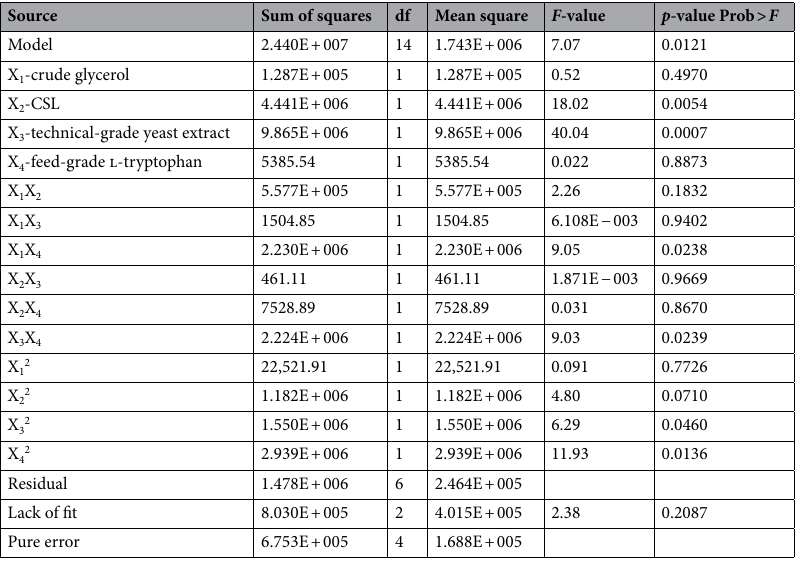
Table 1. Regression analysis quadratic model of CCD. R 2 = 0.9429, Adjusted R 2 =